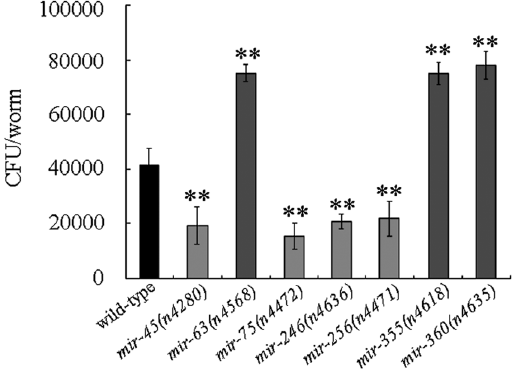
Figure 2. P. aeruginosa PA14 CFU in the body of miRNA mutants infected with P. aeruginosa PA14. Bars represent mean ± SD. ** P < 0.01 vs